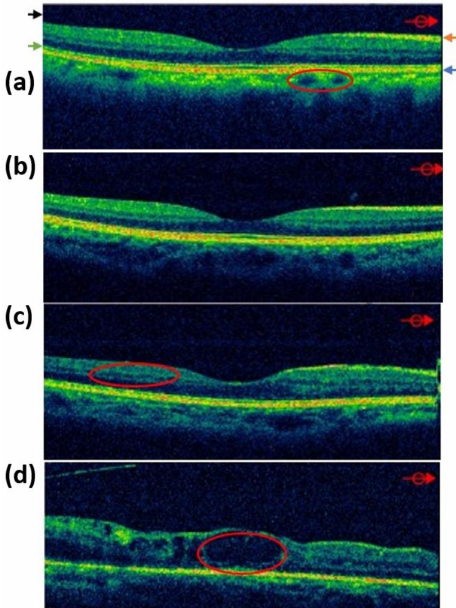
Figure 3. Optical coherence tomography (OCT) images of ( a ) Normal, ( b ) BDR, ( c ) PPDR, and ( d )